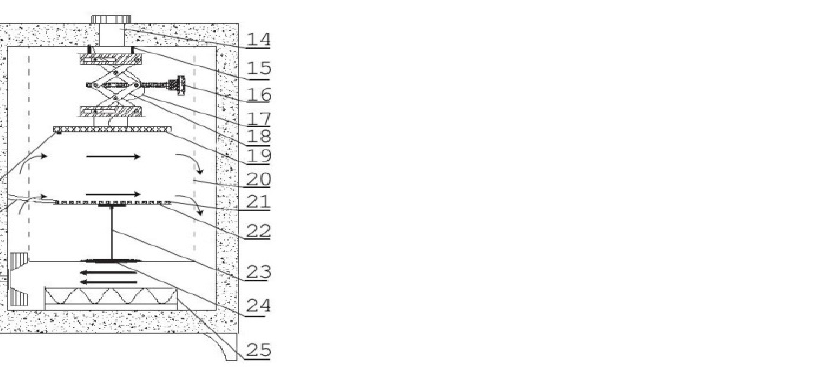
Figure 1. Schematic diagram of infrared radiation drying equipment. (1) Drying chamber stand, (2) thermal insulating layer, (3) fan, (4)thermocouple, (5) thermal sensor, (6) switch, (7) temperature display panel, (8) auxiliary heating switch, (9) fan controller,(10) temperature control panel, (11) infrared radiation heater switch, (12) heater temperature controller, (13) cabinet, (14)exhaust port, (15) tighting screw, (16) knob, (17) heater’s cable,(18) blacket, (19) infrared radiation board, (20) drying chamber, (21) material, (22) material tray, (23) support rod, (24) supporter, (25) electric heater.